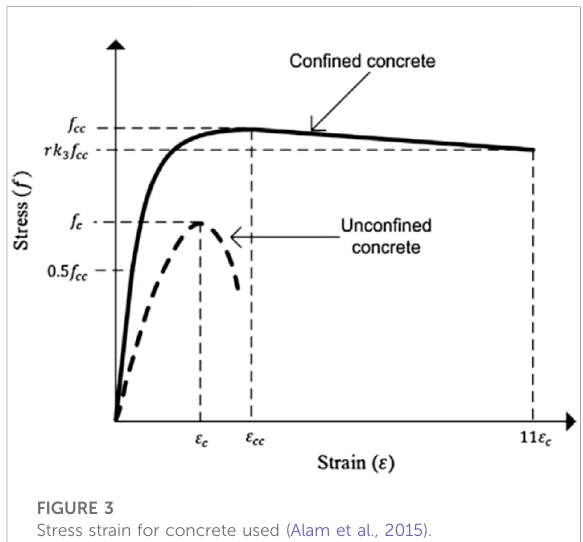
FIGURE 3 Stress strain for concrete used (Alam et al.,